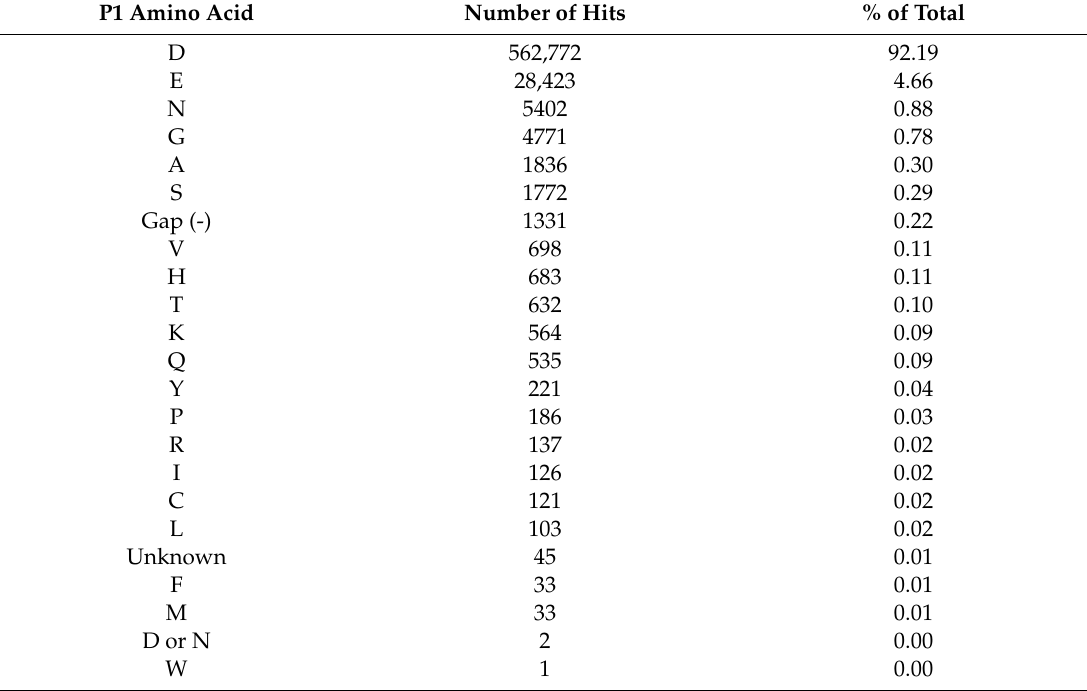
Table 1. Distribution of amino acids in the P1